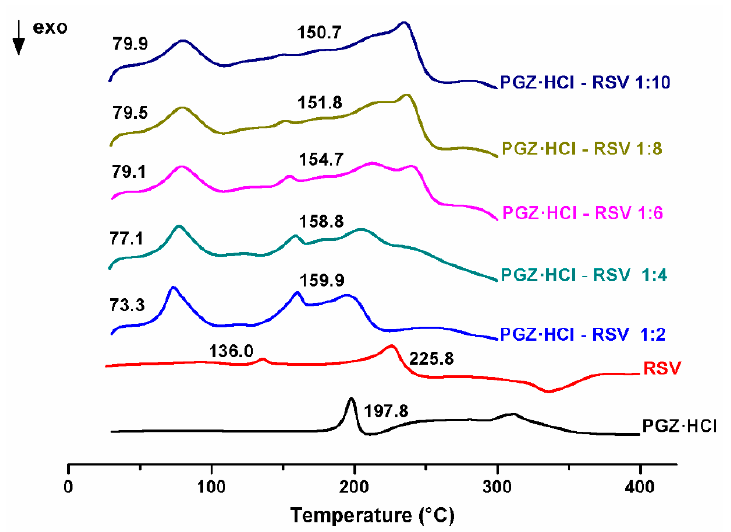
(Figure 6). Individual thermograms of DSC-TGA of all these solid forms are presented in Figure S7. The thermodynamic data are contained in Table 3.